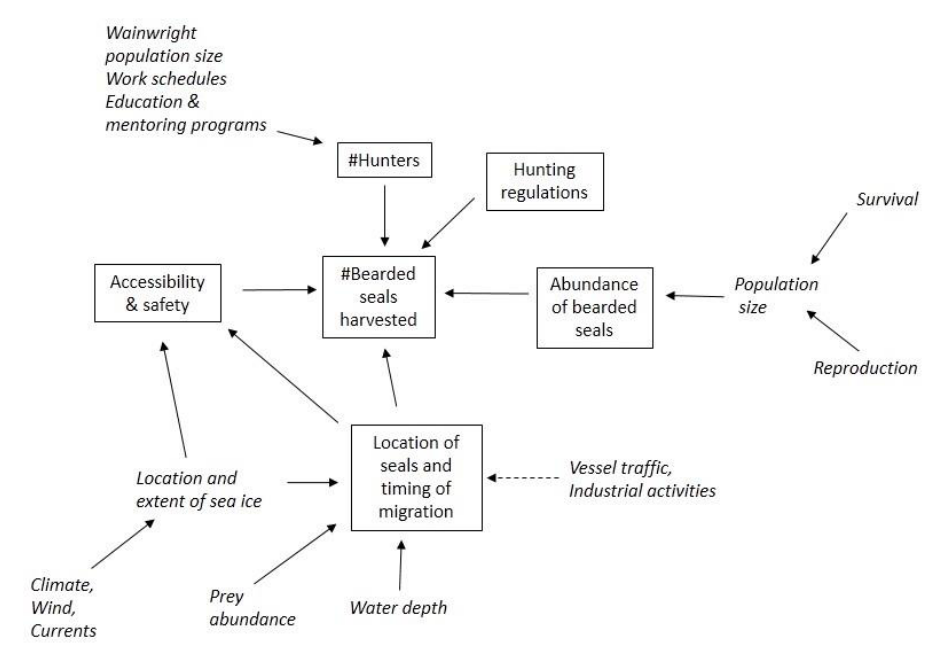
Figure A1.4. Model of bearded seal subsistence system in Wainwright,